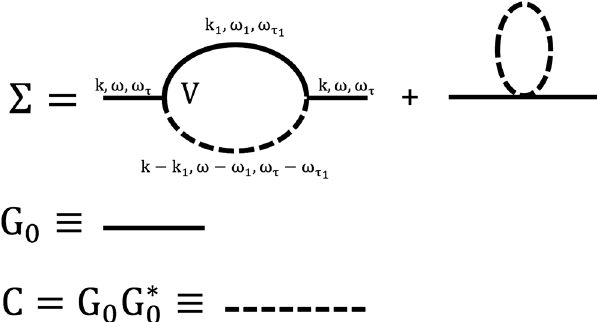
FIG. 19. The diagrams correspond to perturbation expansions of the theory [Eq. (C3)], in which the dynamical equations for the density field are expressed in fictitious time. The self-energy term ( Σ ) is obtained by contracting the two density ρ fields. The first diagram is the two loop contribution generated from the first order term (which contains two ρ fields) in the time-dependent equation for the density fields. The second diagram, with a one loop contribution from the second order term (which contains three ρ fields), resulting in the correction to ω 2 þ f C 0 k 2 U ð k Þ − ð k a − 2 k b C 0 Þg 2 , does not have any new momentum